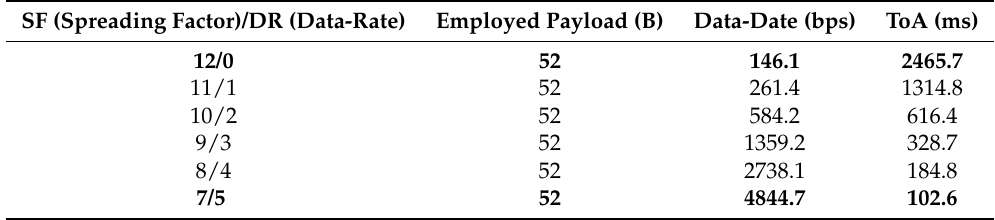
Table 1. LoRa (Long Range) transmissions’ data-rate and ToA (Time-on-air) for the employed payload and BW (Bandwidth) of 125